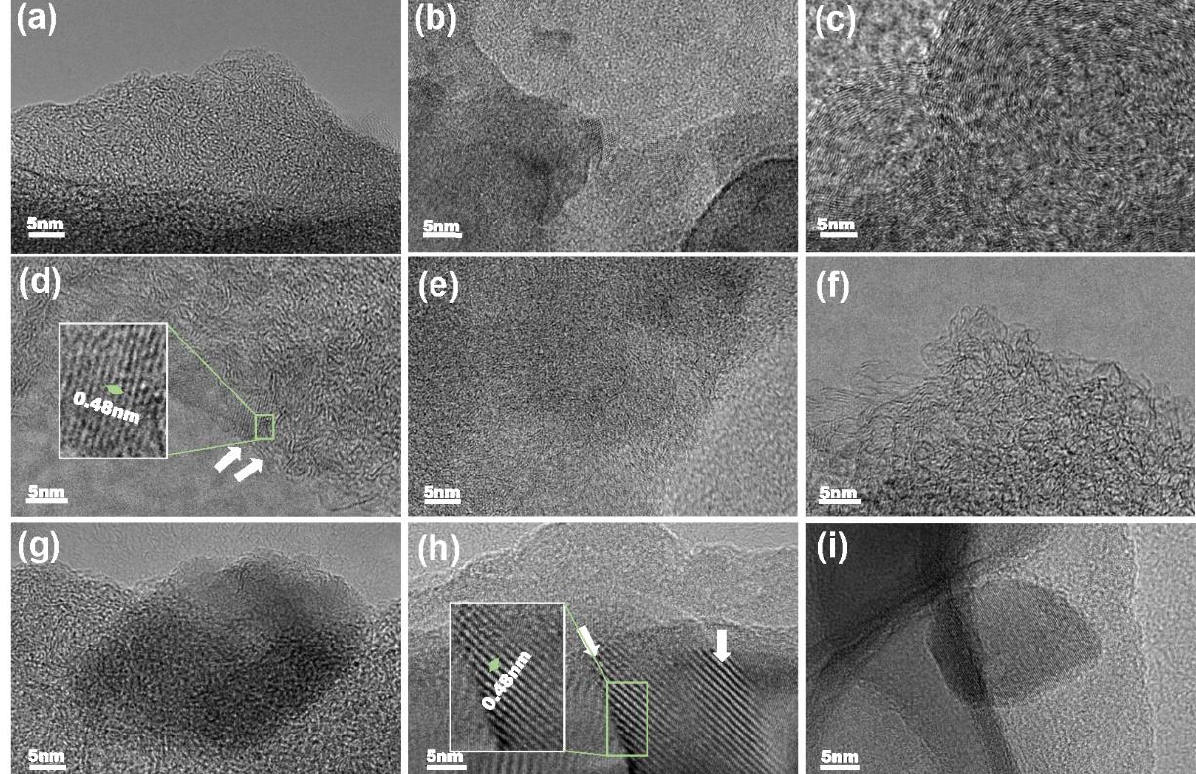
Figure 4. TEM images of Bare AC ( a – c ), 2-cycle ZnO-coated AC at 70 °C ( d – f ), and 20-cycle ZnO-coated AC at 70 °C ( g – i ).